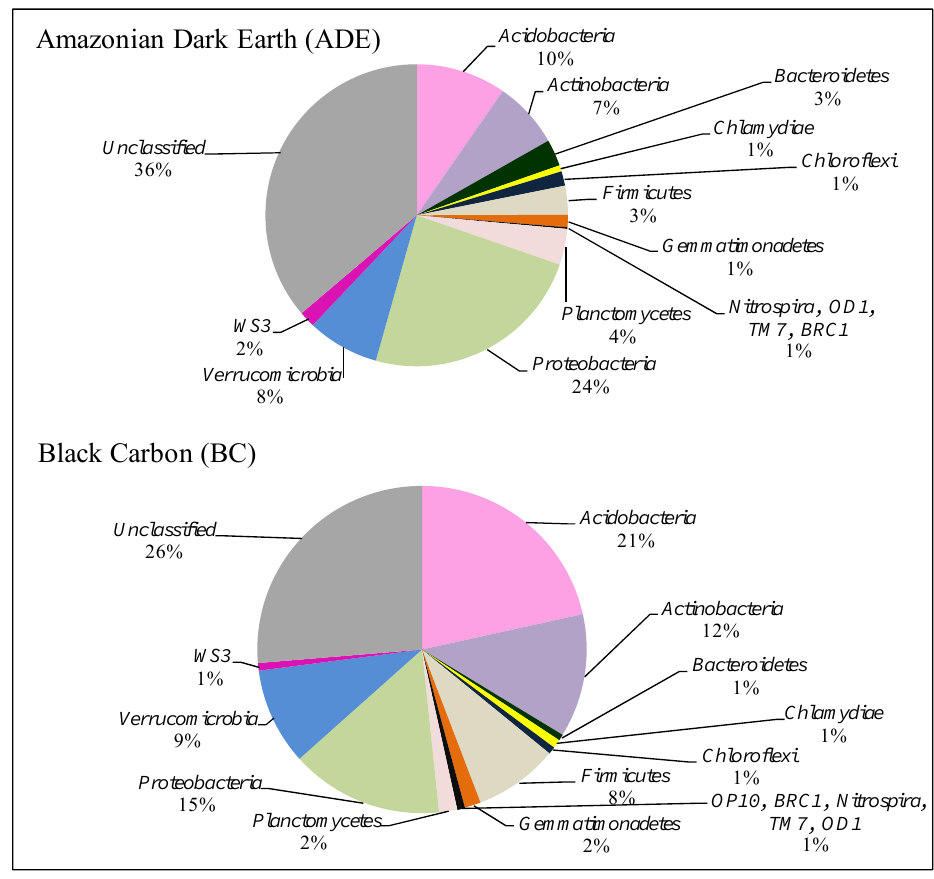
Figure 6. Relative abundance of phyla for ADE soil and BC pyrosequencing library, in which 16S rRNA gene sequences were classified according to the nearest neighbor in the Ribosomal Database Project (RDP-MSU, USA)